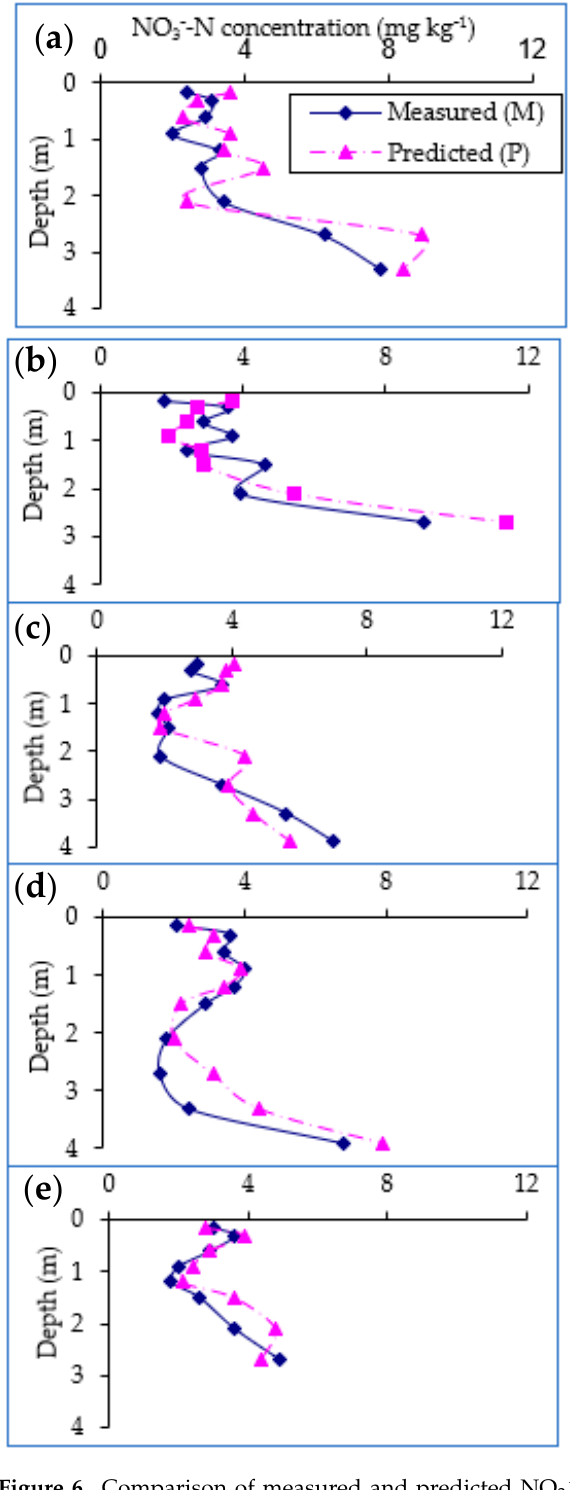
Figure 6. Comparison of measured and predicted NO 3 − -N concentration (mg kg − 1 ) across the soil profile on 21/09/2004 of sampling site ( a ) Ghumana village ( b ) Sainsowal Khurd ( c ) Jattiwal ( d ) Jodhwal ( e ) Bhulewal.